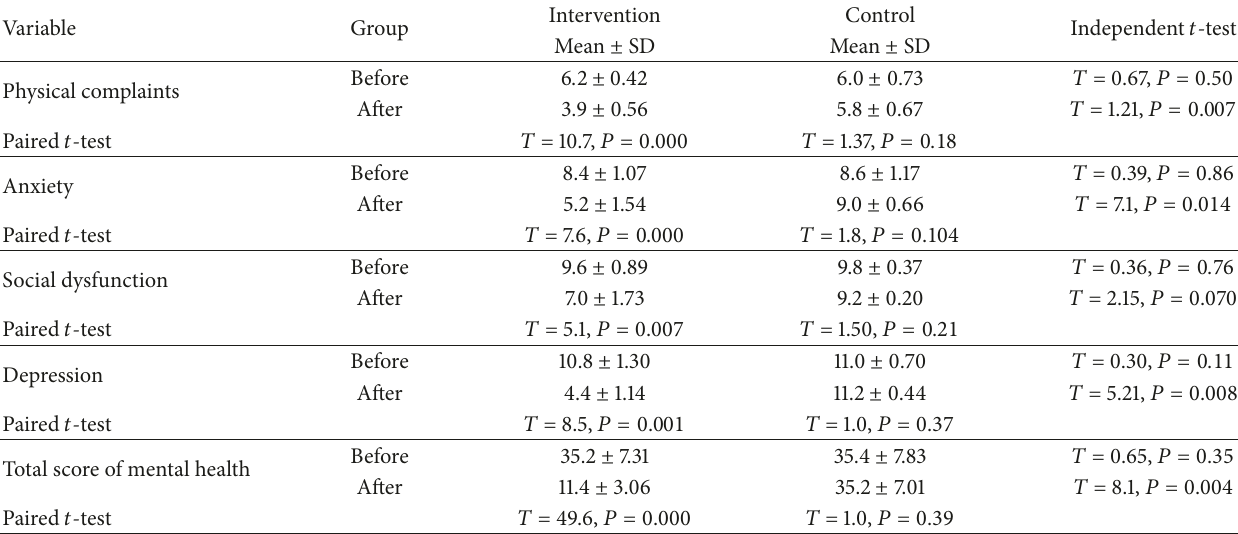
Table 3: Comparison of mental health and its subscales in the intervention and control groups before and after intervention.